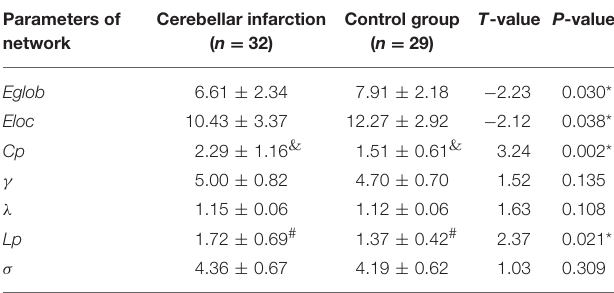
TABLE 2 | Structural network parameters in the cerebellar infarction and control